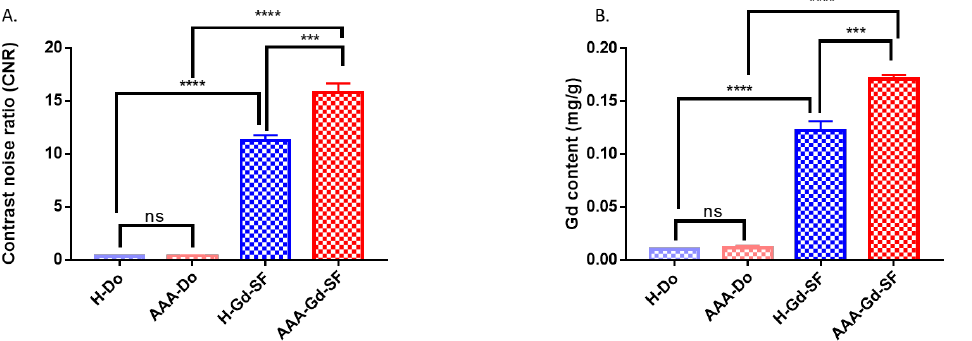
Figure 8. Comparison of the CNRs of the T1-weighted MR images among the four groups of rat healthy abdominal aorta and abdominal aortic aneurysm immersed in either Dotarem or Gd-SF (H- Do, AAA-Do, H-Gd-SF and AAA-Gd-SF) ( A ). Comparison of gadolinium concentrations accumulated in healthy abdominal aorta and abdominal aortic aneurysm immersed in either Dotarem or Gd-SF (H-Do, AAA-Do, H-Gd-SF, and AAA-Gd-SF) using ICP/MS measurements ( B ). ( n = 3 per study group. One-way ANOVA; ns, not significant; *** p < 0.001, and **** p < 0.0001.).